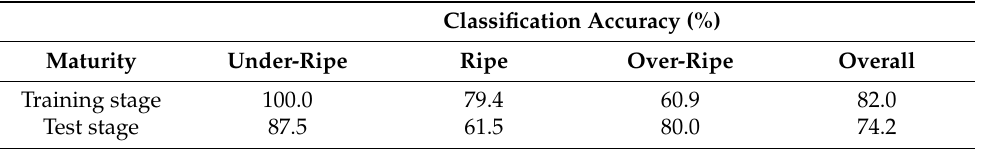
Table 10. The classification accuracy of the training stage and test stage for KNN.